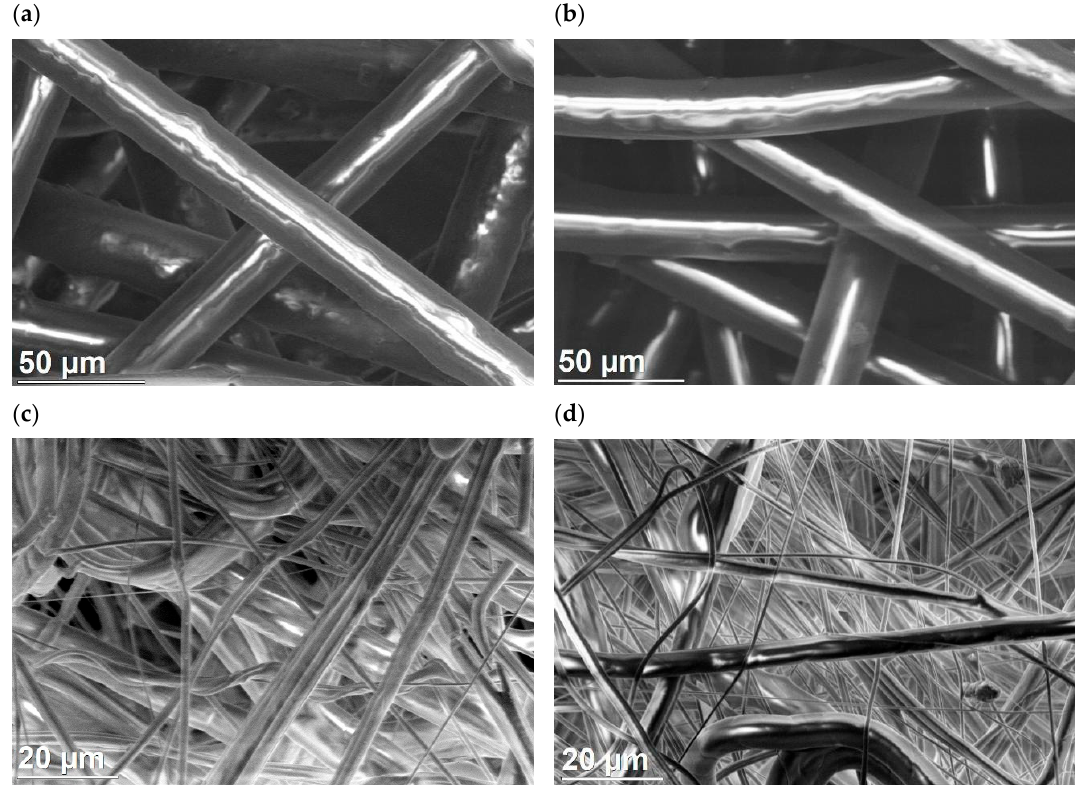
Figure 11. SEM images of filters. Outer layer before ( a ) and after ( b ) sterilization. Internal layer before ( c ) and after ( d ) sterilization.